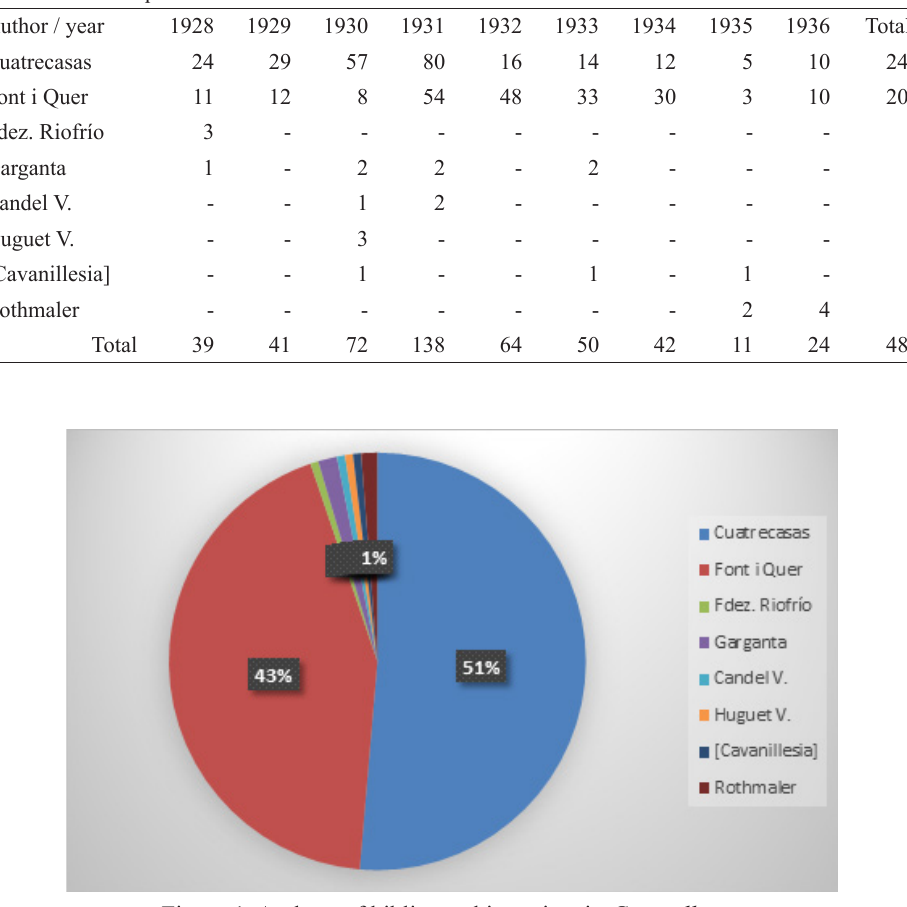
Figure 1. Authors of bibliographic review in Cavanillesia .